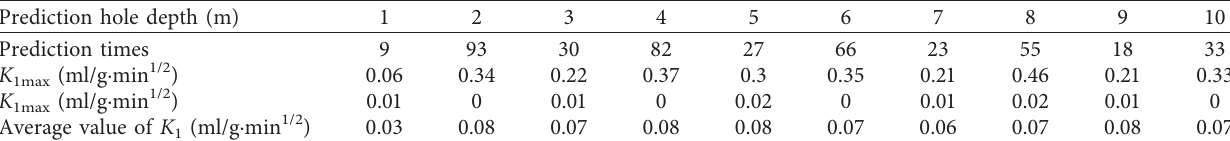
1 with changing hole